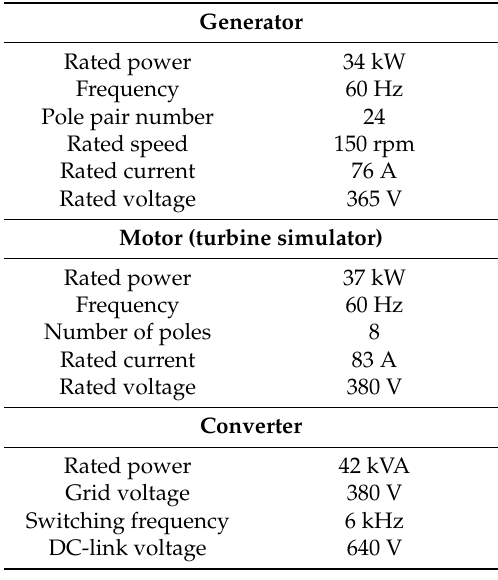
Table A2. Test bench